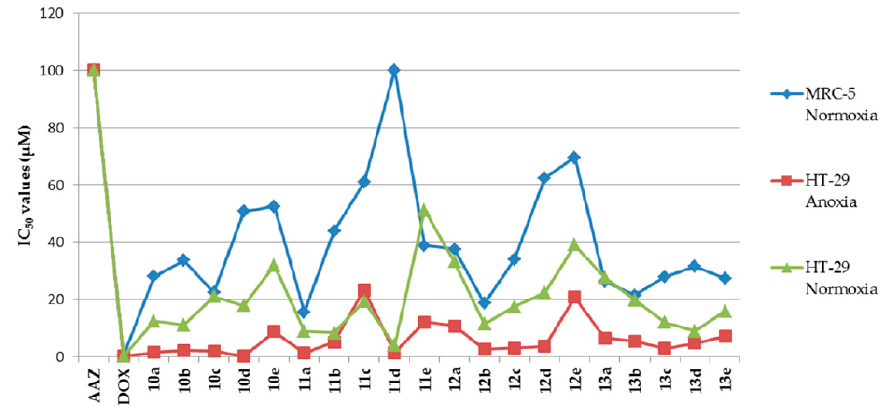
Molecules 2016 , 21 , 758